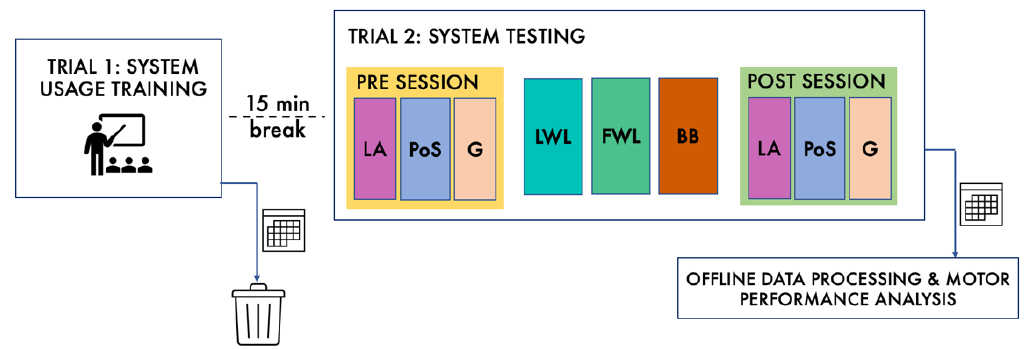
Figure 2. Schematic summary of the experimental protocol: during Trial 1, subjects were trained in using the system (collected data were discarded); Trial 2 consisted of two evaluative sessions before (PRE) and after (POST) testing of the exergames (collected data were offline processed and analyzed to evaluate motor performance at the